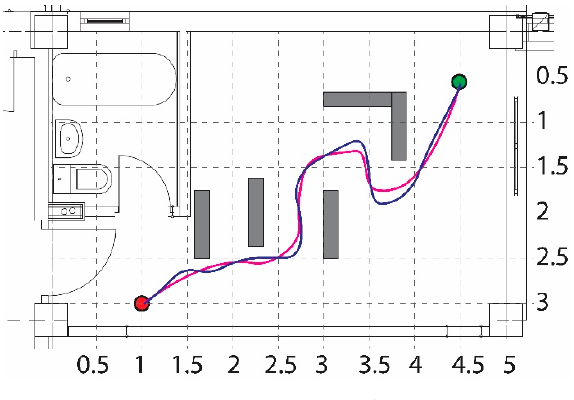
Figure 13. Corner avoidance.